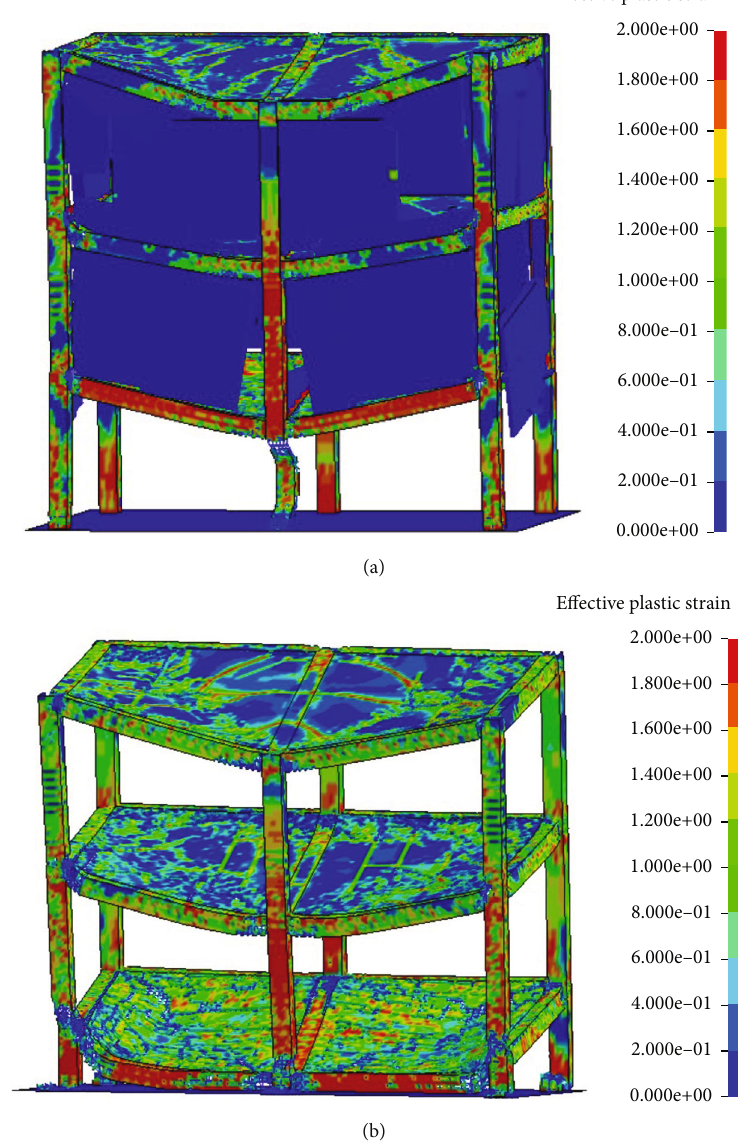
Figure 5: Collapse state of the frame when the middle column at ground fl oor is damaged. (a) Frame 1. (b) Frame